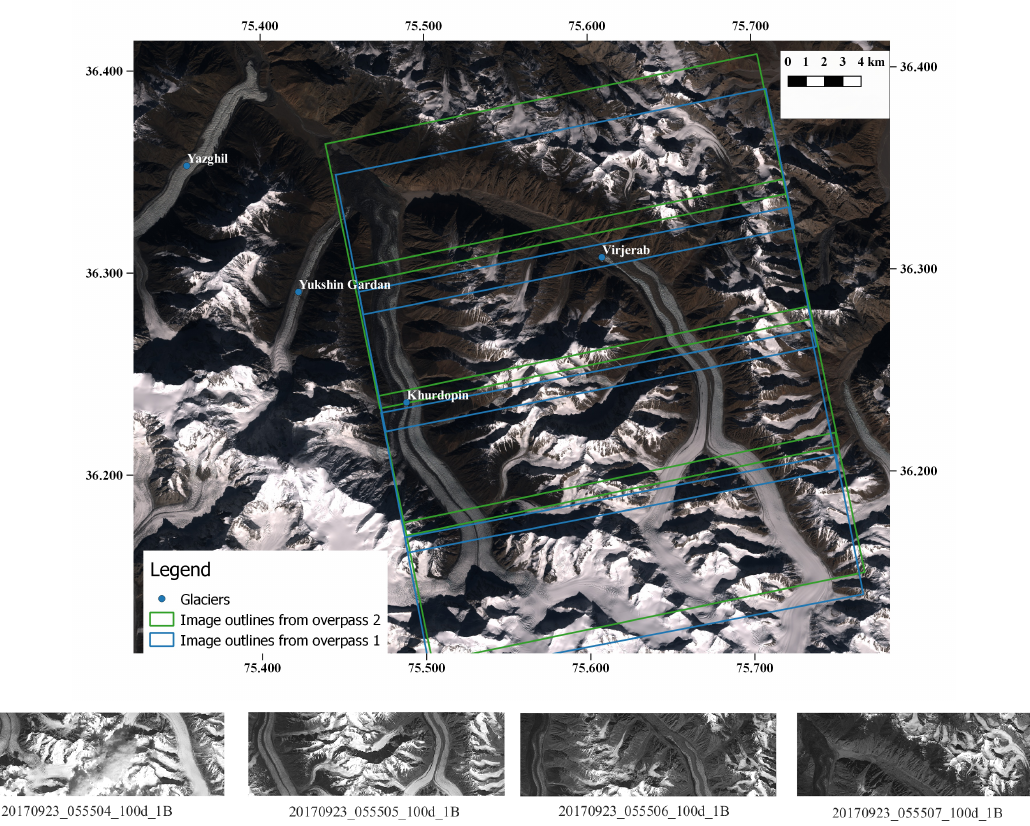
Figure 17. A Sentinel image of the Khurdopin Glacier along with the extent of PlanetScope images from two overpasses. Bottom: Four PlanetScope Images of a single overpass (green outlines) over Khurdopin